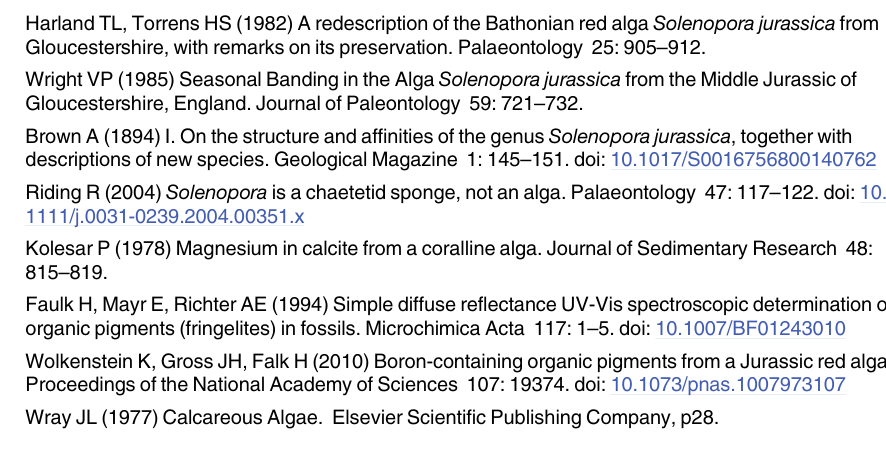
S1 Fig. EPMA maps of the pink and white bands of S. jurassica . White represents high abun- dances and black represents low abundances. (TIFF) S2 Fig. Synchrotron rapid scanning X-ray fluorescence maps of the ‘ lighter ’ elements in UOM-232 with a photographic reference of the area scanned. White represents high abun- dances and black represents low abundances. (TIFF) S3 Fig. Synchrotron rapid scanning X-ray fluorescence maps of the ‘ heavier ’ elements in UOM-232 with a photographic reference of the area scanned. White represents high abun- dances and black represents low abundances.